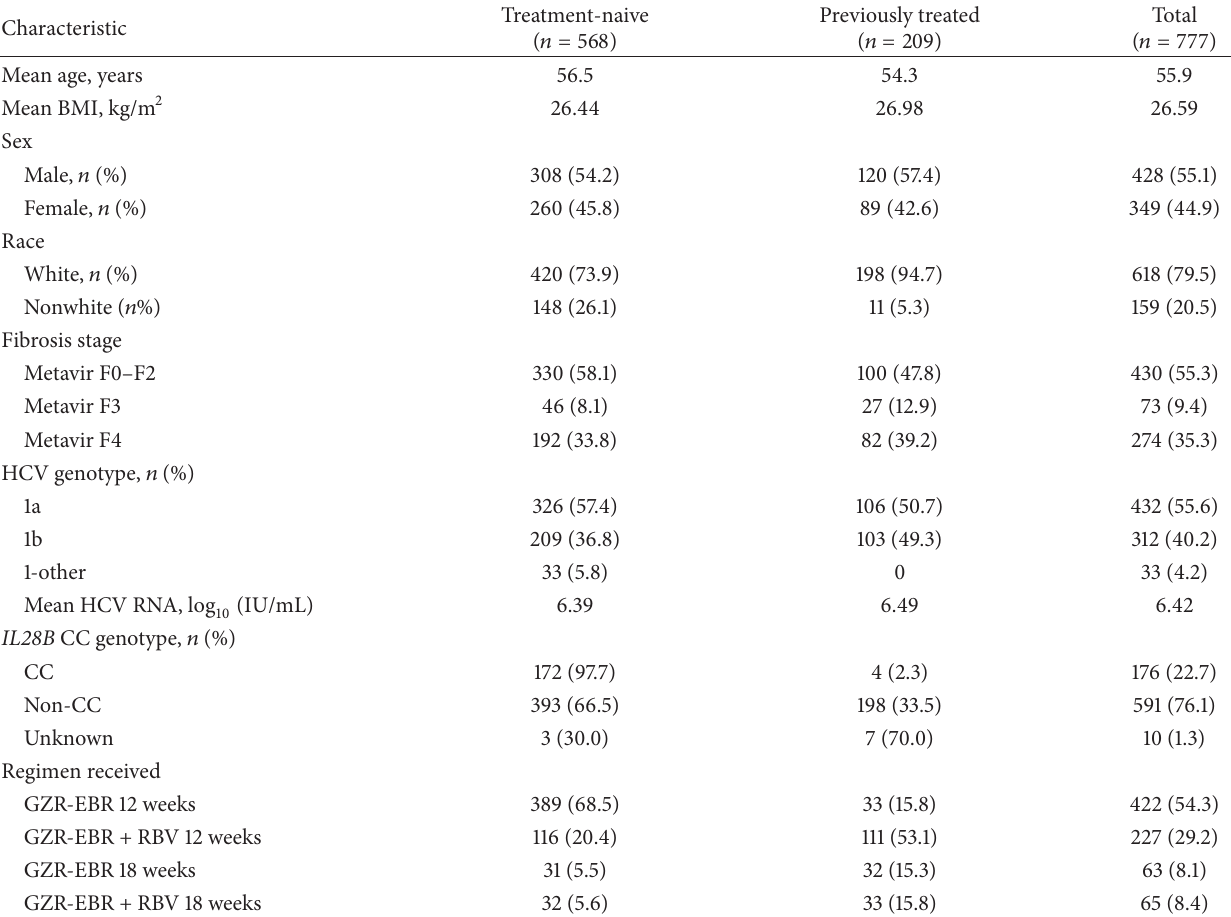
Table 1: Baseline demographic